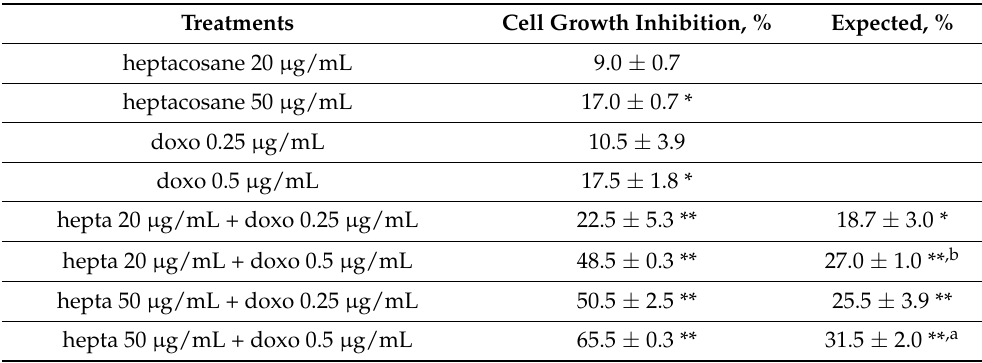
Table 4. Results of cell counting analysis in HL-60R cells following 48 h of treatment with heptacosane (hepta) and doxorubicin (doxo), either alone or in combination.